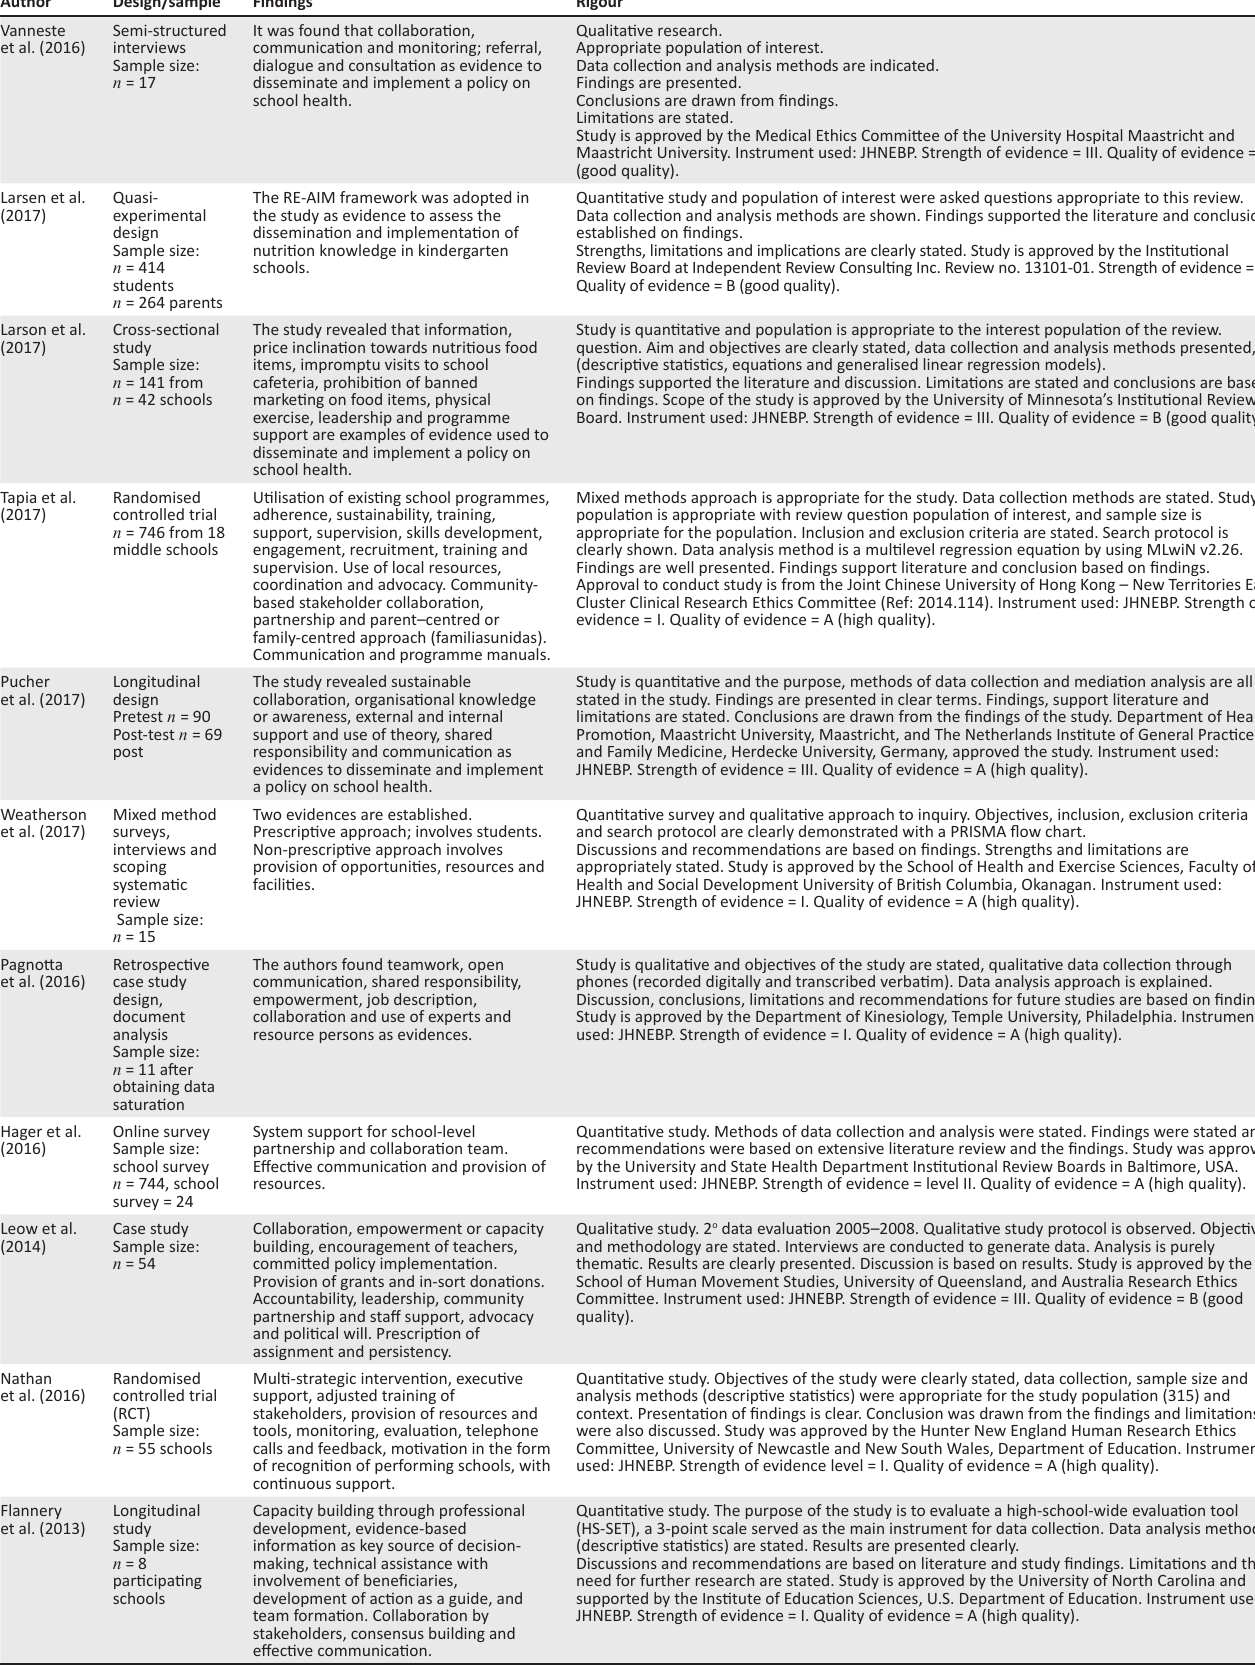
TABLE 2: Evidence table of studies included for